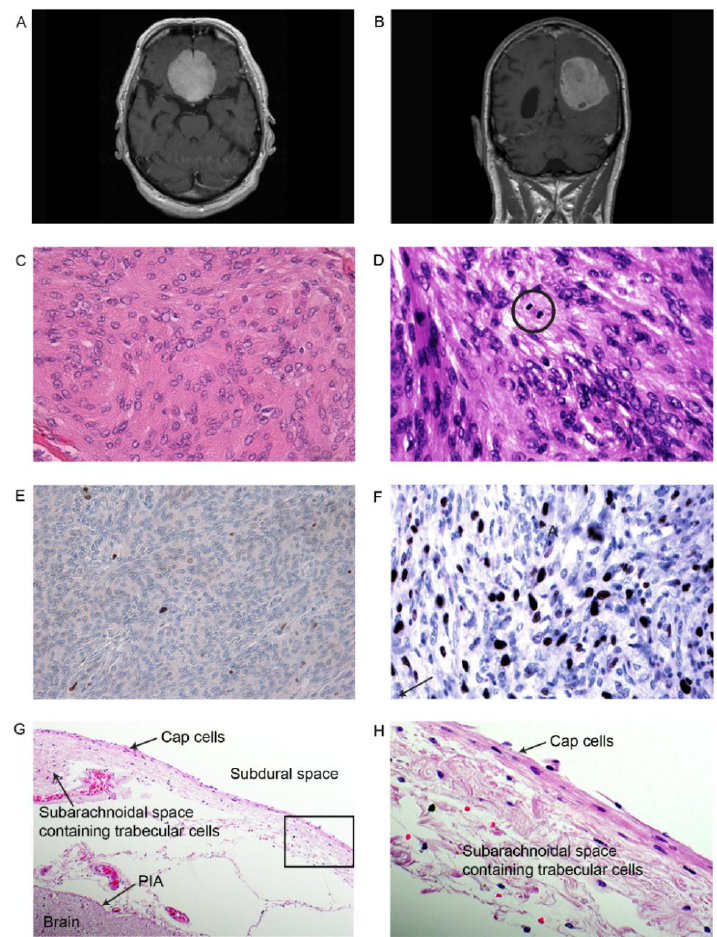
Figure 1. Tumors of the two patients used for sequence analysis. Tumor from patient 1 (IA) presented to the left ( A , C and E ), and tumor from patient 2 (II) to the right ( B , D and F ); ( A ) and ( B ) show the Magnetic resonance imaging (MRI) for patients 1 and 2 (Table 1); ( C ) Meningothelial meningioma grade I with lobules of uniform meningioma cells with typical intranuclear inclusions. Hematoxylin and eosin stain (HE), 400 ˆ ; ( D ) Atypical meningioma grade II with atypical features and scattered mitoses. HE, 600 ˆ ; ( E ) Very few immunoreactive tumor cells for the proliferation marker Ki-67 in this grade I tumor, 200 ˆ ; ( F ) Elevated activity for the proliferation marker Ki-67 in this grade II meningioma (200 ˆ ); ( G ) The normal arachnoid contains an external layer of horizontally oriented cap cells (200 ˆ ). Traversing the subarachnoid, a loose web-like tissue containing trabecular cells, fibrous tissue and vessels that fuse with the inner Pia mater covering the brain surface; ( H ) The enlarged marked section in G at 400 ˆ showing the horizontally oriented external cap cells in the arachnoid